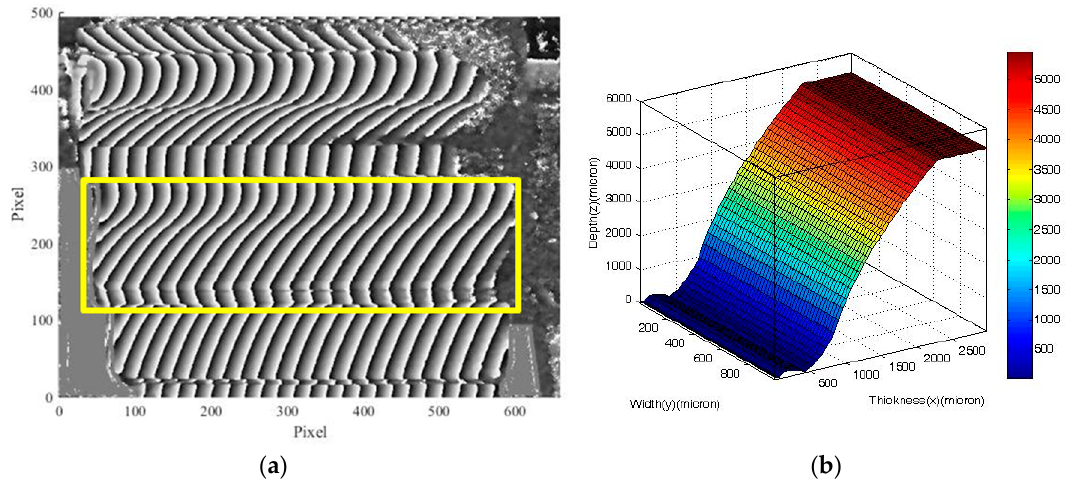
Figure 8. ( a ) Wrapped phase map on the gear tooth surface and the region of interest; ( b ) reconstructed 3-D tooth surface.